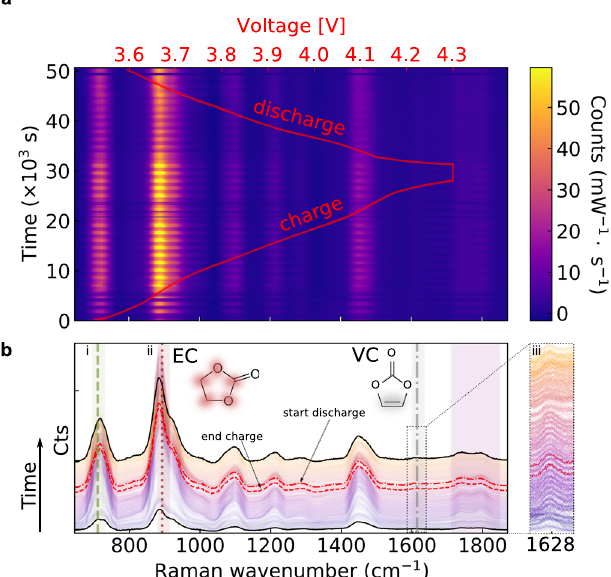
Fig. 3 Battery electrolyte Raman spectral evolution during cycling. a , Operando Raman spectroscopy performed during the formation cycle for a LiNi 0.8 Co 0.1 Mn 0.1 O 2 (NMC811) - graphite Li-ion pouch cell with an electrolyte comprising LP57 + 2 wt.% VC. The cell was charged galvanostatically to 4.3V, potentiostatically held at 4.3V, and then discharged. b , Raman spectral evolution showing a range of Raman modes of battery electrolytes, particularly: ( i ) PF 6 − anion, symmetric stretch (740cm − 1 , green dashed line), ( ii ) EC, skeletal breathing mode (893cm − 1 , dotted red line), ( iii ) VC, -HC = CH- (1628cm − 1 , grey dash-dotted line, displayed in inset where the signal was multiplied by 4, relative to that shown in